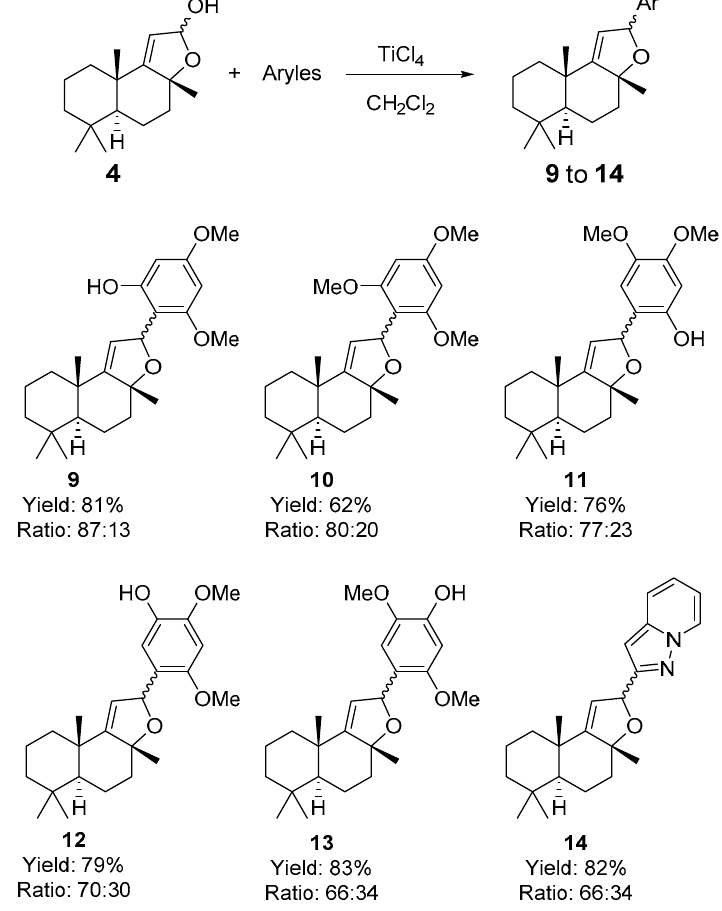
5 of 13 Figure 3. Structure of the major isomer 8ab determined by single-crystal X-ray diffraction, CCDC code: 2,236,373 [34]. In view of the robust reactivity of electron-rich indoles in TiCl 4 mediated coupling to 4 , other electron-rich aromatic rings were further examined and the results are summa- rized in Scheme 2. Gratifyingly, polyphenol methyl ethers are good substrates and ex- pected conjugation products 9–13 were obtained in good yields with isomer ratios rang- ing from 66:34 to 87:13.